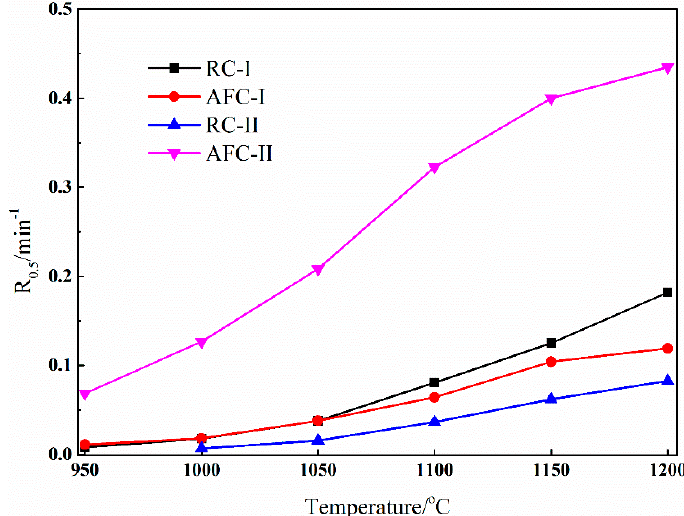
Figure 2. The reactivity index for raw coals (RCs), ash-free coals (AFCs).